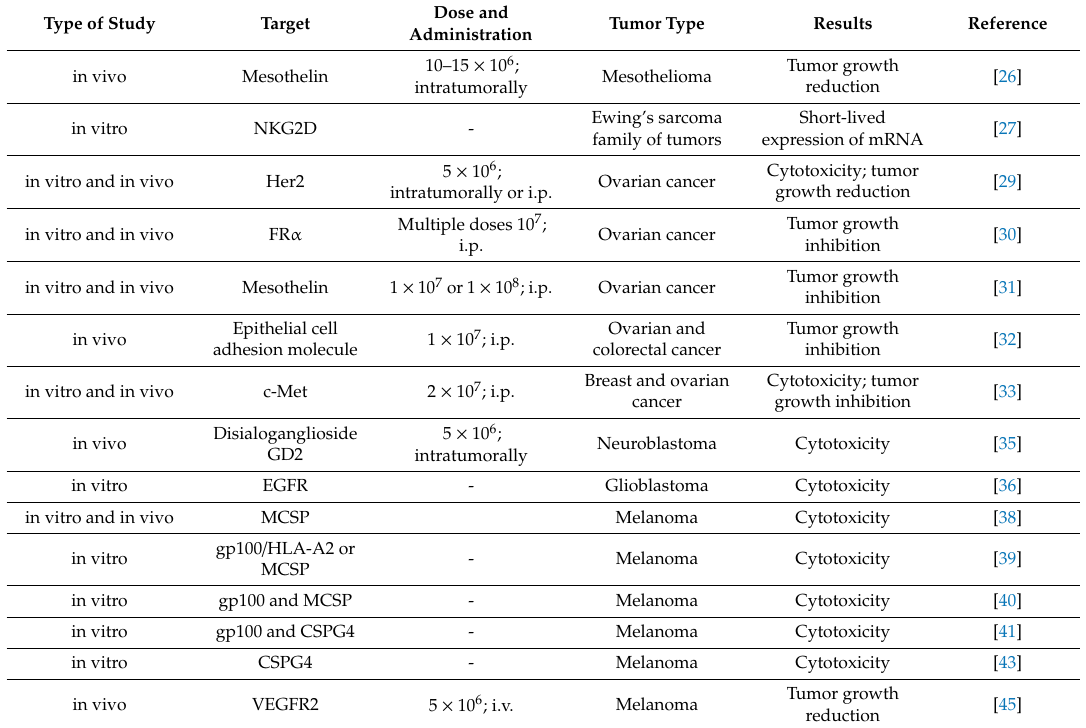
Table 2. Preclinical studies regarding the e ff ects of IVTmRNA CAR T cells in solid malignancies (i.p., intraperitoneal; i.v.,